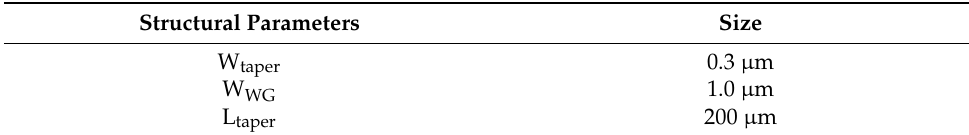
Table 1. Structural dimensions of the inverse tapered edge coupler.